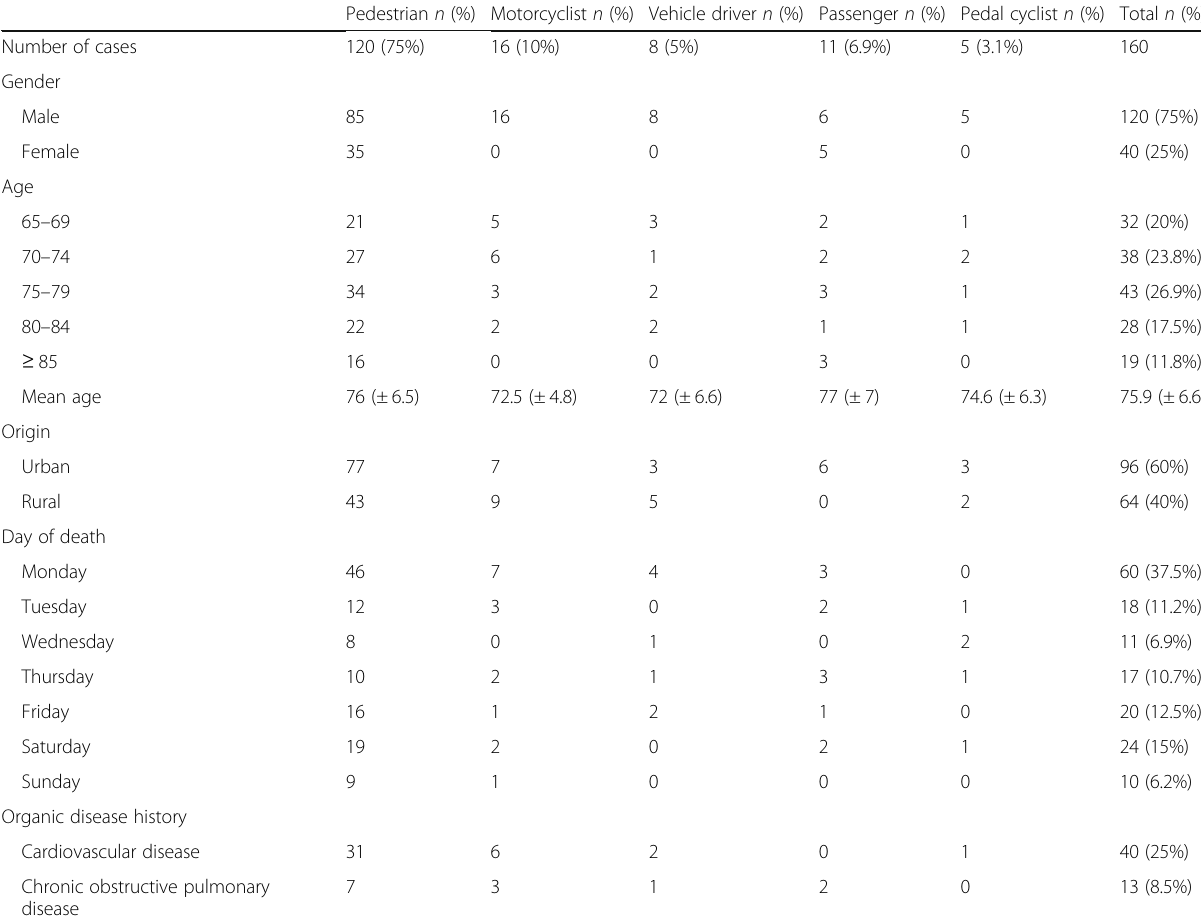
Table 2 Distribution of traffic accidents epidemiological